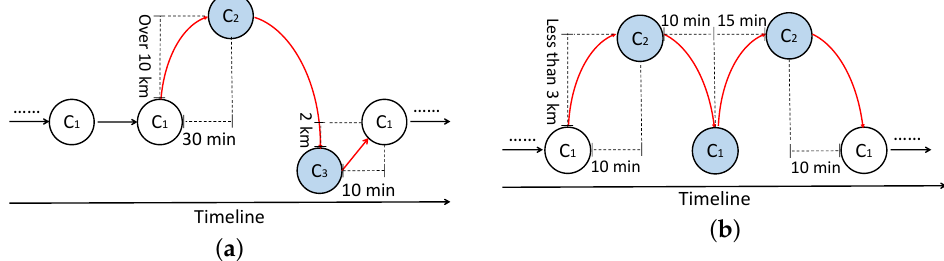
Figure 1. Two real examples of oscillations. ( a ) Cells jump to a far away tower then return back; ( b ) cells swift between two nearby towers.